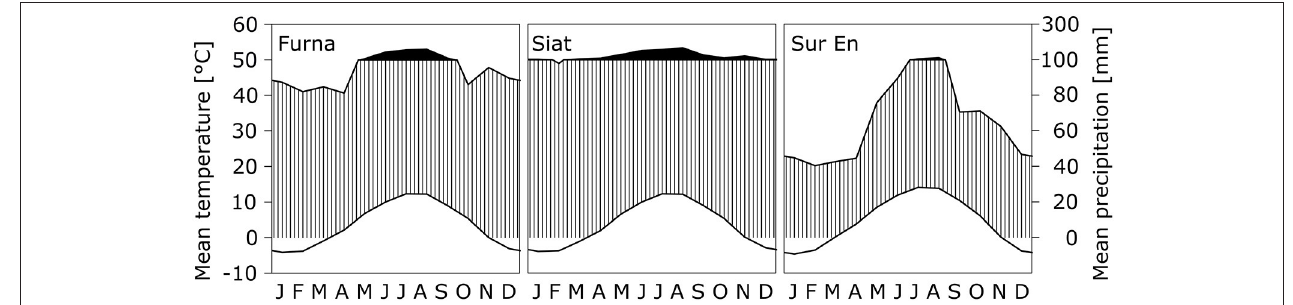
FIGURE 1 | Walter-Lieth climate diagrams representing the long-term averages (from 1970 to 2016) of monthly air temperature Ta (upper line) and monthly precipitation sum Pr (lower line) at the study sites Furna, Siat (both Upper Rhine Valley), and Sur En (Lower Engadine). The vertical axes for Ta and Pr are scaled with a ratio of 1:2, as after Walter and Lieth (1960–1967) a month is classified as arid if Ta in ◦ C exceeds two times Pr in mm. Black areas indicate periods with Pr > 100mm, and white areas show periods with Ta < 0 ◦ C. Note that the vertical axis is broken at Pr = 100